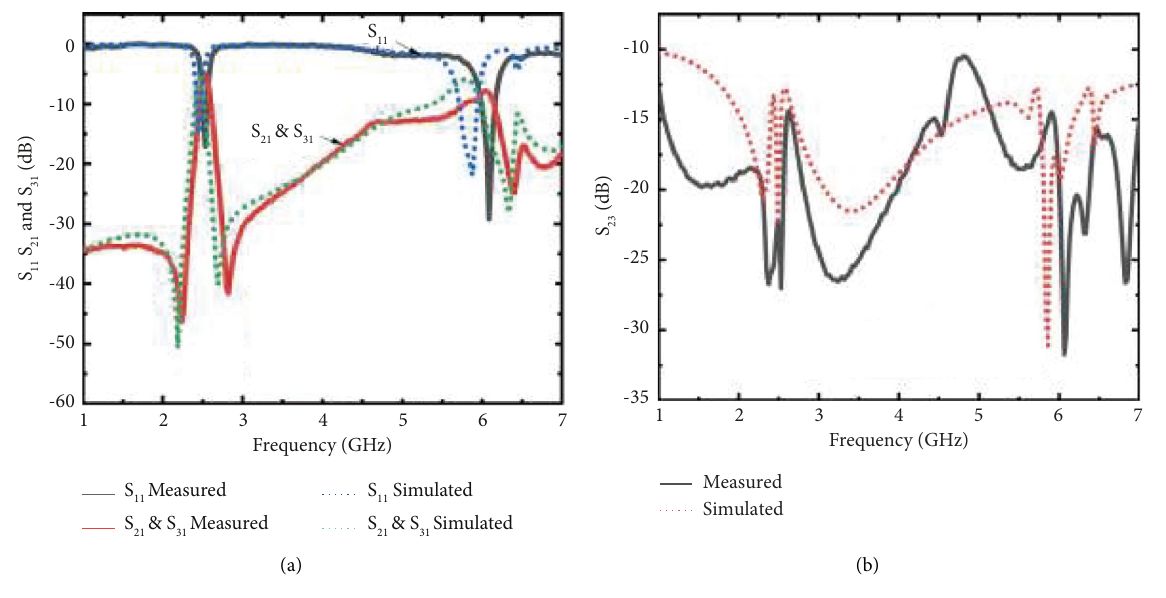
Figure 9: Measured and simulated S-parameters. (a) S